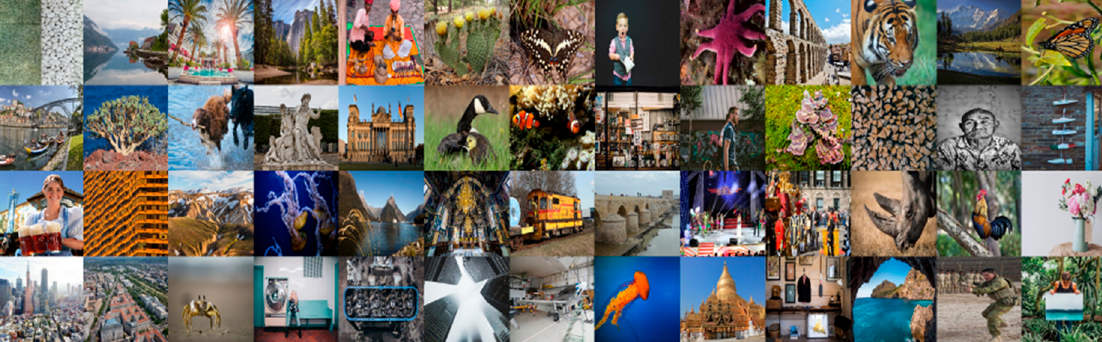
Figure 4. Training dataset. (DIV2K).